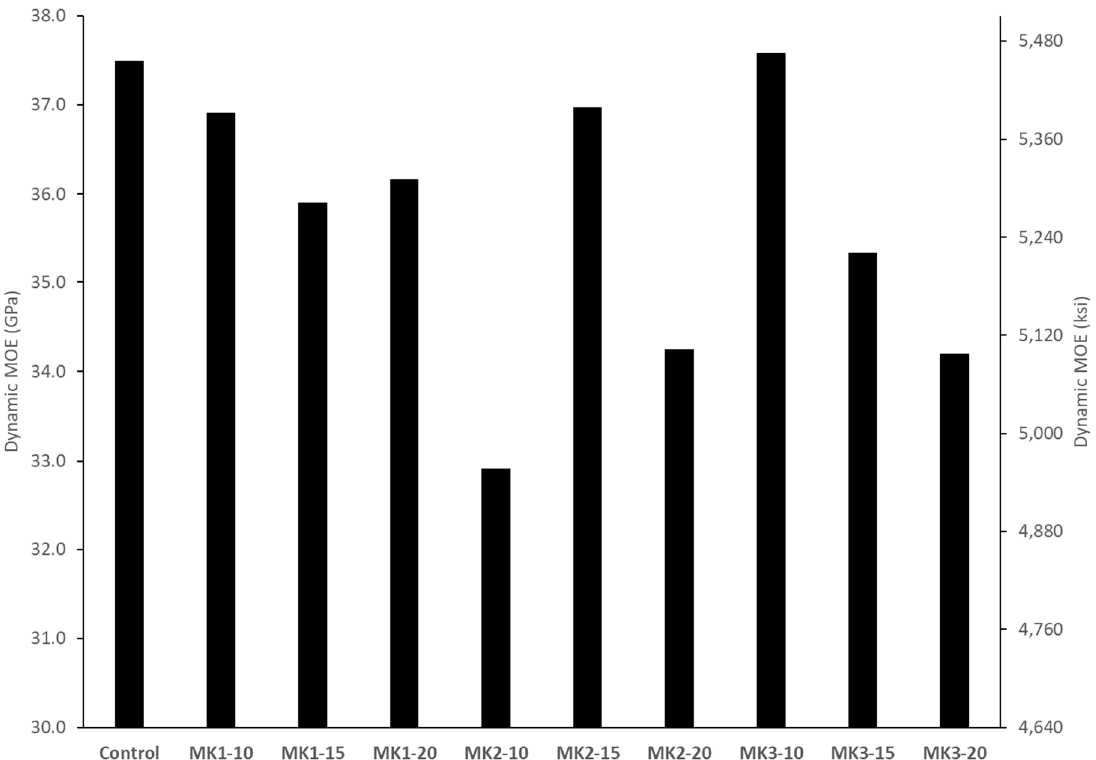
Figure 5. Young’s moduli of metakaolin concretes as measured by forced resonance method.